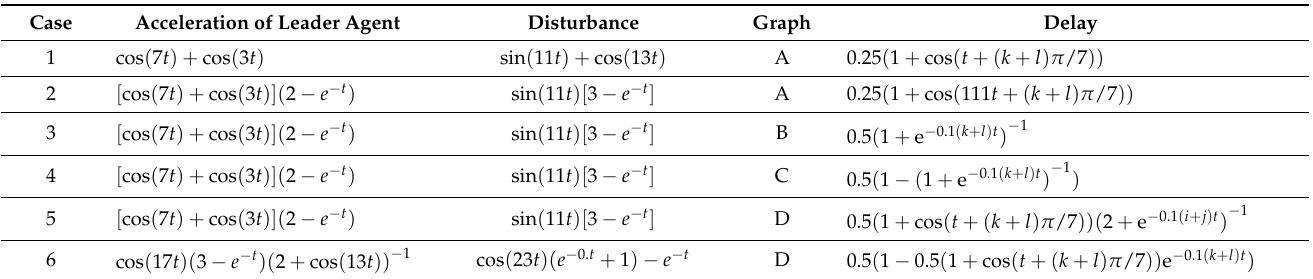
Table 1. Simulation system configurations with the acceleration of the leader agent, disturbance, communication graph, and delay. k and l are the indices of two connected